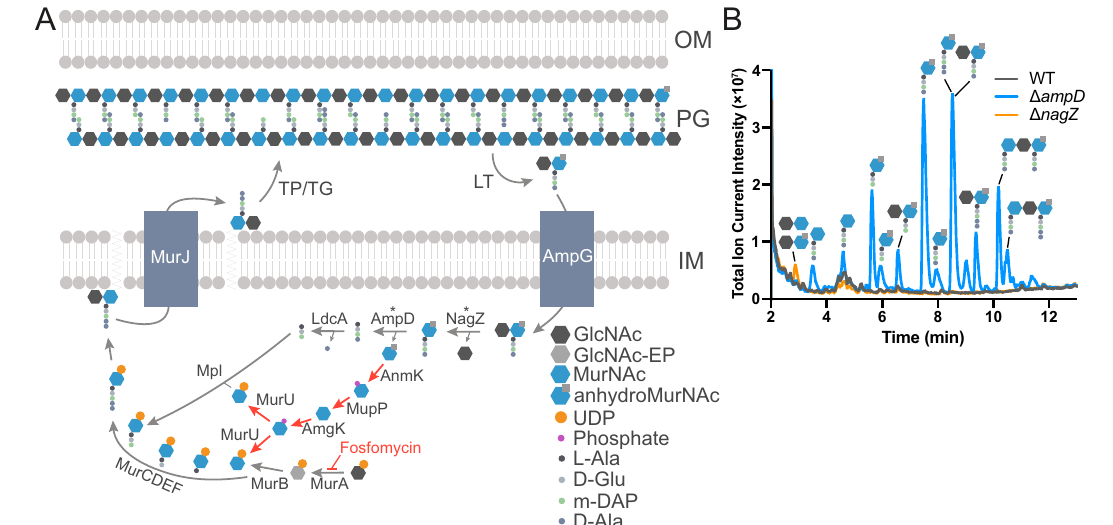
Fig. 1 | A. tumefaciens recycles muropeptides. A Schematic diagram of PG recy- clingpathwayin E.coli . Pseudomonas MurNAcrecyclingpathwaydepictedwithred arrows. EP enolpyruvate, TP transpeptidase, TG transglycosylase, LT lytic trans- glycosylase, OM outer membrane, PG peptidoglycan, IM inner membrane. * AmpD and NagZ activities are promiscuous: AmpD can act on muropeptides with or